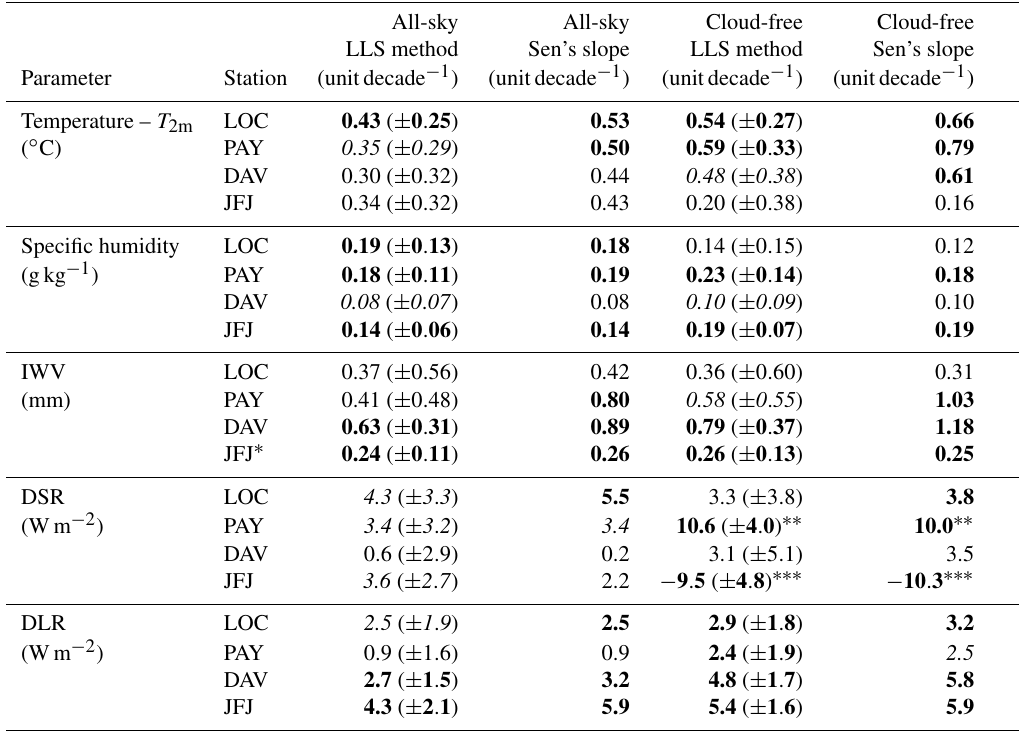
Table 3. Trend analyses (linear least-squares – LLS – and Sen’s methods) of selected parameters for the 1996–2015 period during all-sky and cloud-free conditions at all four stations. Trend values in italics (bold) are significant at the 90% (95%) level. The 90% confidence interval of each trend is shown in brackets for the LLS method.